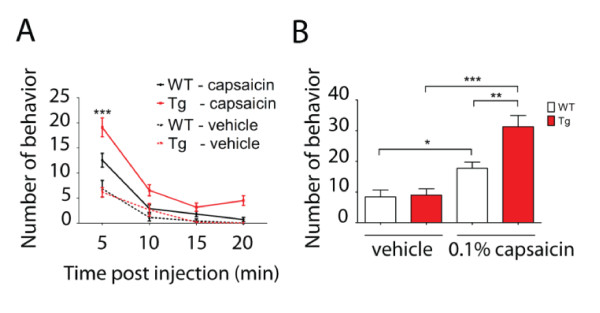
Visceral hyperalgesia in transgenic mice induced by intracolon injection of capsaicin. Behavioral reactions (abdominal licking, stretching, squashing the lower abdomen against floor and abdominal retractions) evoked by intracolonic injection of vehicle solution or 0.1% capsaicin in WT and Tg mice. A. Number of behaviors observed in each 5 min period over a total observation time of 20 min post-administration. ***Indicates the other three groups which were significantly different from capsaicin-treated Tg mice during the first 5 min observation period (p < 0.001). B. Number of behaviors observed in the total 20 min period post-administration. Data are shown as mean ± s.e.m. (n = 5-11, *p < 0.05, **p < 0.01, ***p < 0.001).